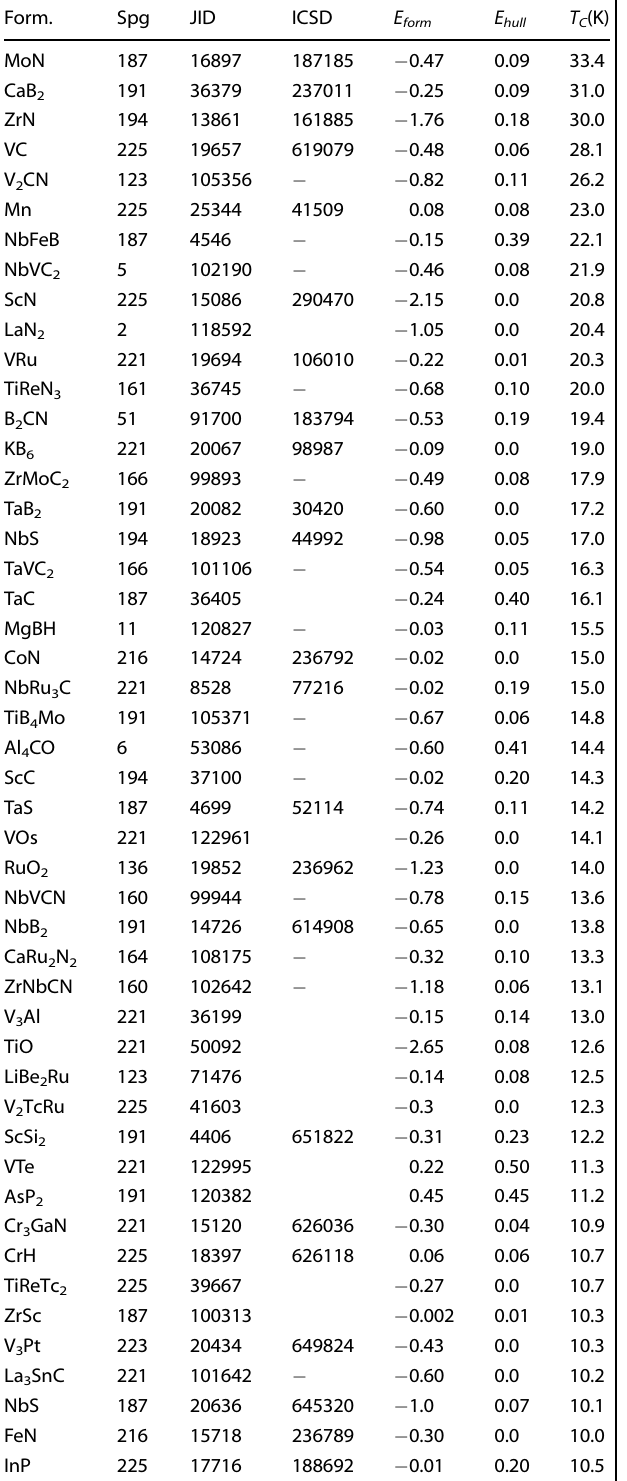
Table 2. JARVIS-Tools screening work fl ow based T C for some of the potential candidate superconductors ( T C ), their chemical formula (Form.), spacegroup number (Spg), JARVIS-DFT ID (JID), Inorganic Crystal Structure Database ID (ICSD) 61 wherever available, JARVIS-DFT based formation energy ( E form (eV/atom)) and energy above convex hull ( E hull (eV)). For the complete list, refer to the supplementary